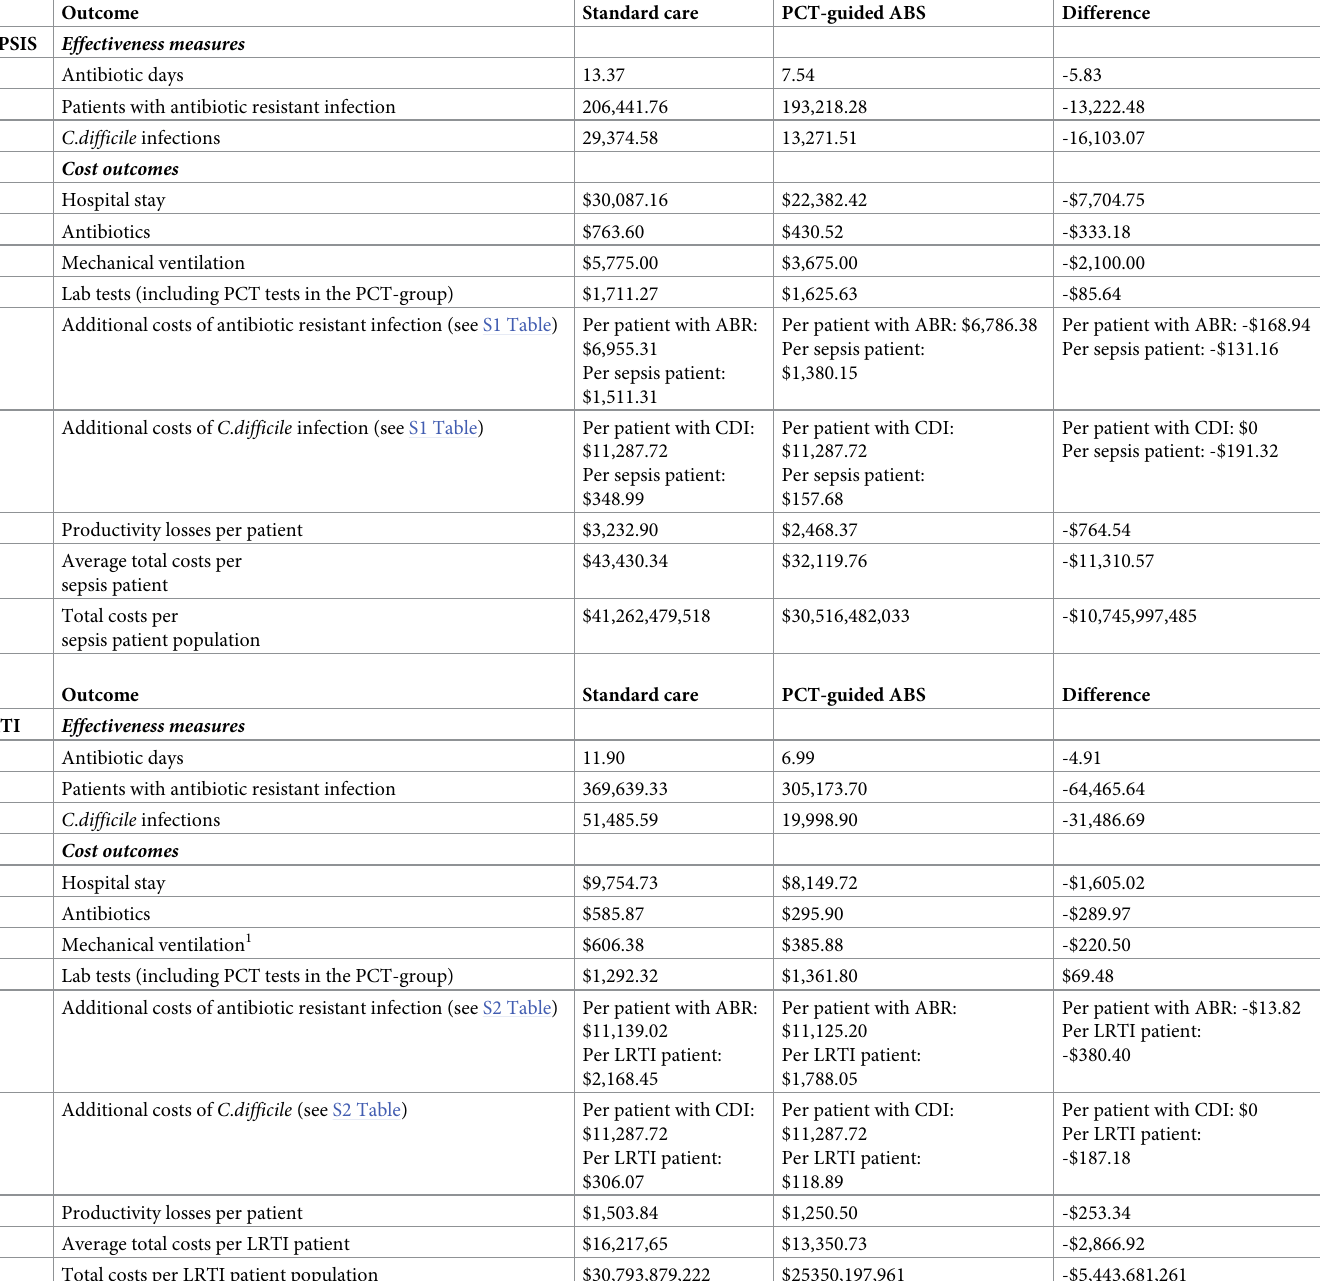
Table 4. Results for patients with sepsis and